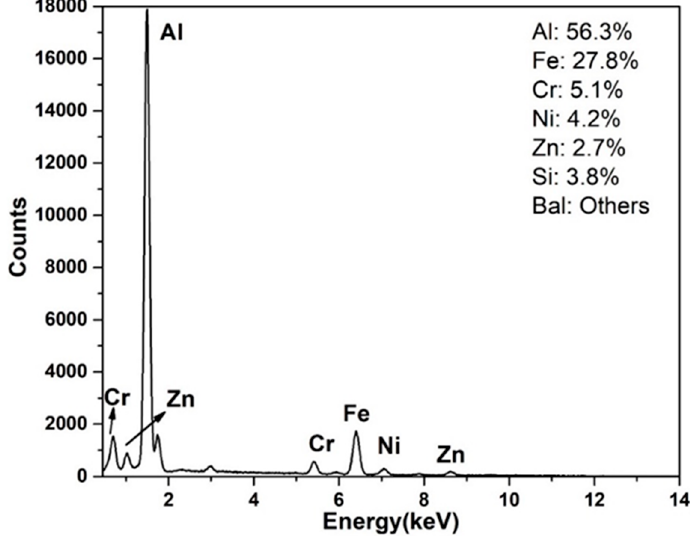
Figure 11. EDS analysis of the IMC layer (AL-2) (See Figure 4).